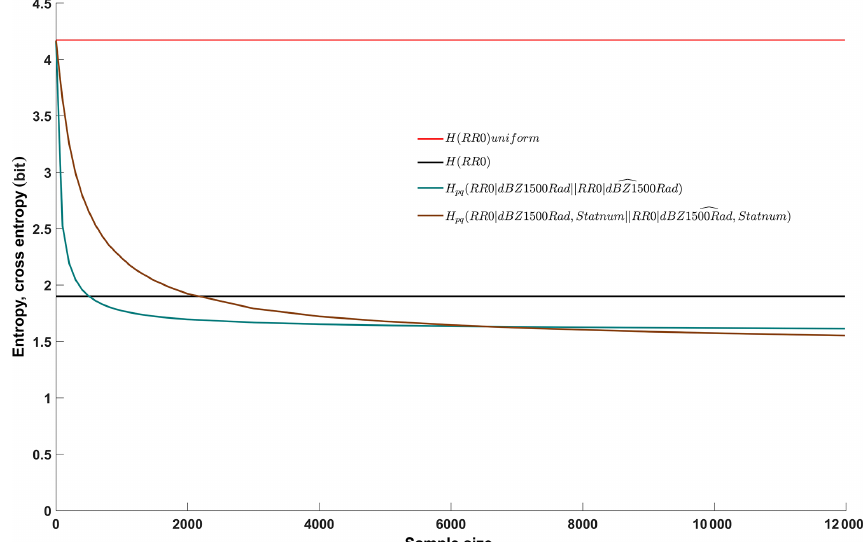
Figure 5. Entropy of the unconditional, target distribution (filtered data set, black line, same as in Fig. 4), entropy of the benchmark uniform distribution (filtered data set, red line, same as in Fig. 4), cross entropies between conditional distributions of the target of the filtered data set and samples thereof: one-predictor model applying dBZ1500Rad (green line, same as in Fig. 4), two-predictor model applying dBZ1500Rad and station number (brown line). The “ ∧ ” symbol indicates a sample.